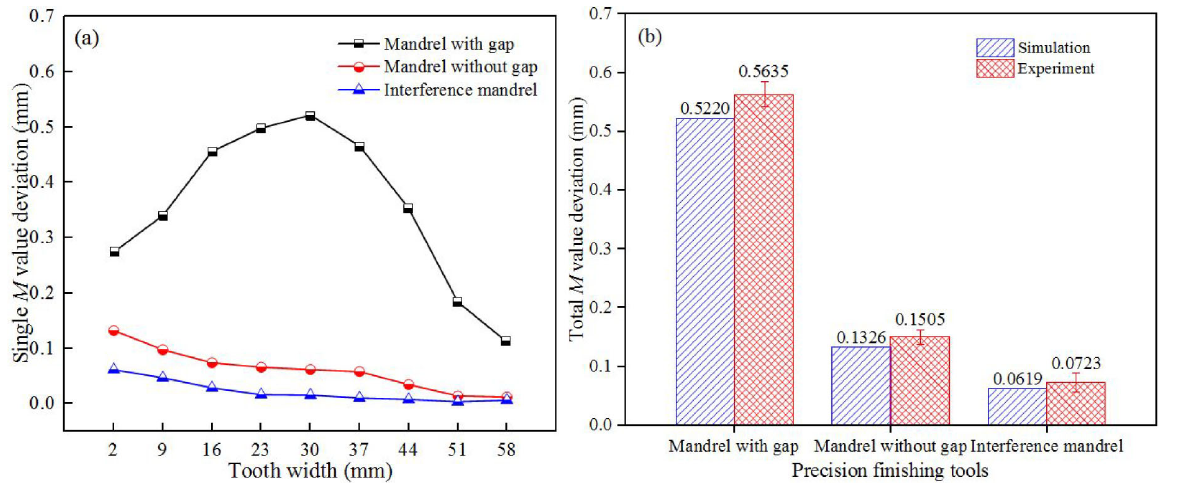
Figure 11. M value deviations of the inner tooth at various finishing tools: ( a ) Single and ( b ) total.